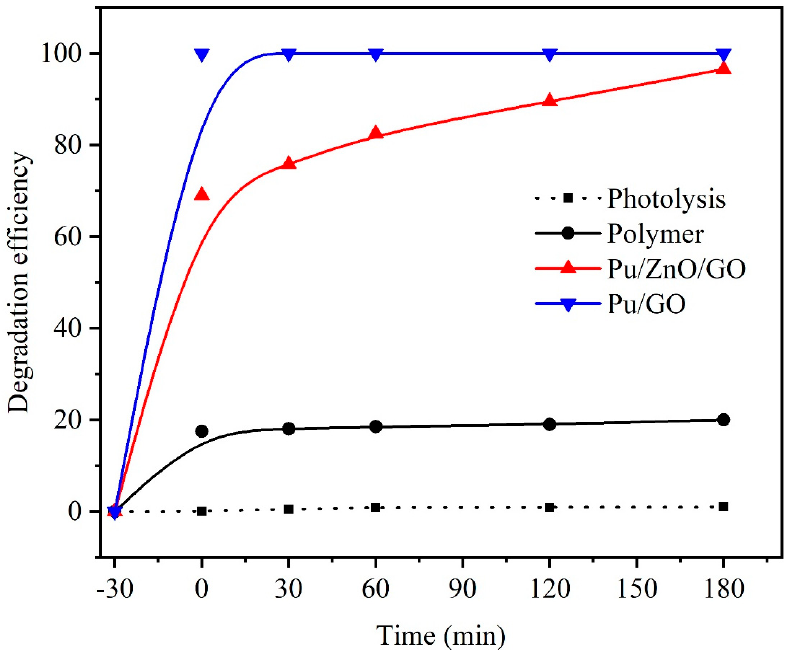
Figure 9. Photocatalytic activity of neat PUF, PUF/GO, and PUF/rGO/ZnO nanocomposites.